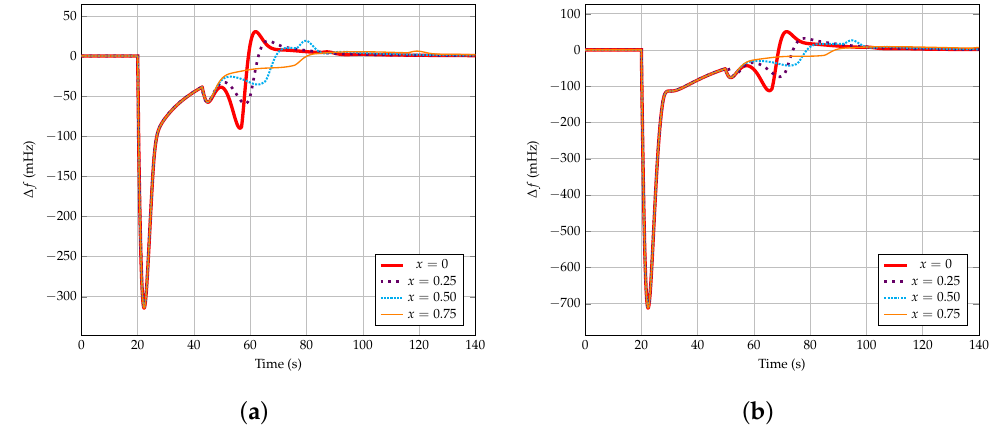
Figure 13. NADIR, stabilization time and ROCOF: comparison for the different Figure 13. Nadir, stabilization time and the rate of change of frequency (ROCOF): comparison for the scenarios without wind power plant control for ∆ P L = 0.050 different scenarios without wind power plant control for ∆ P L = 0.050.